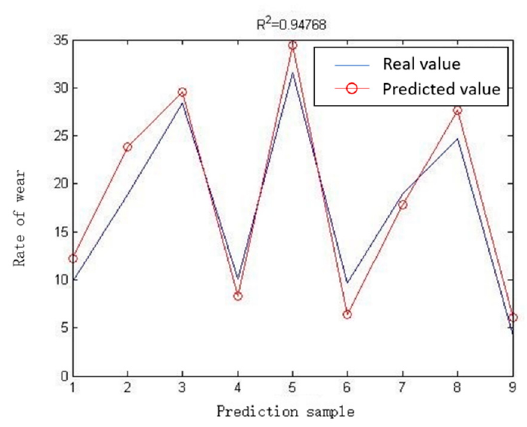
Figure 17. Comparison of the true value of the test sample and the predicted value.